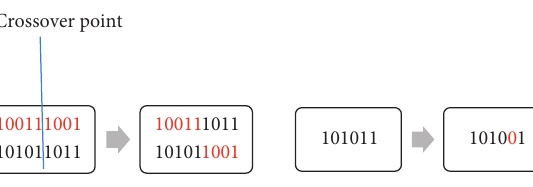
Figure 1: Execution of crossover and mutation operator. Table 1: Iterative values with characteristic points of Example 1.